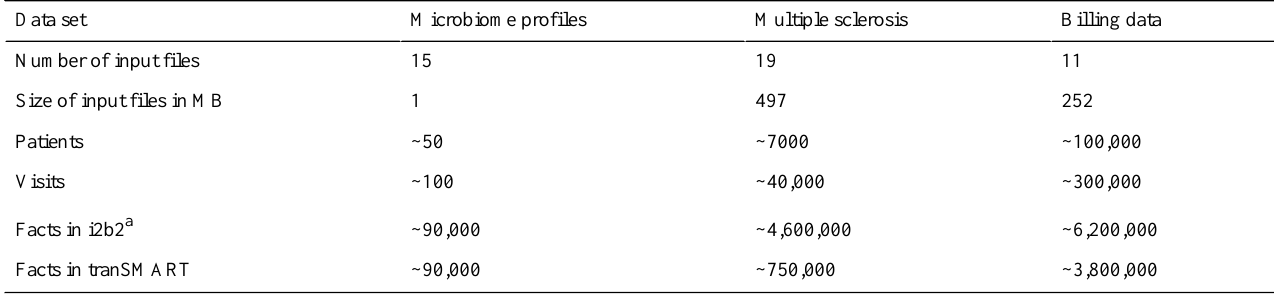
Table 1. Overview of the properties of the data sets used in the